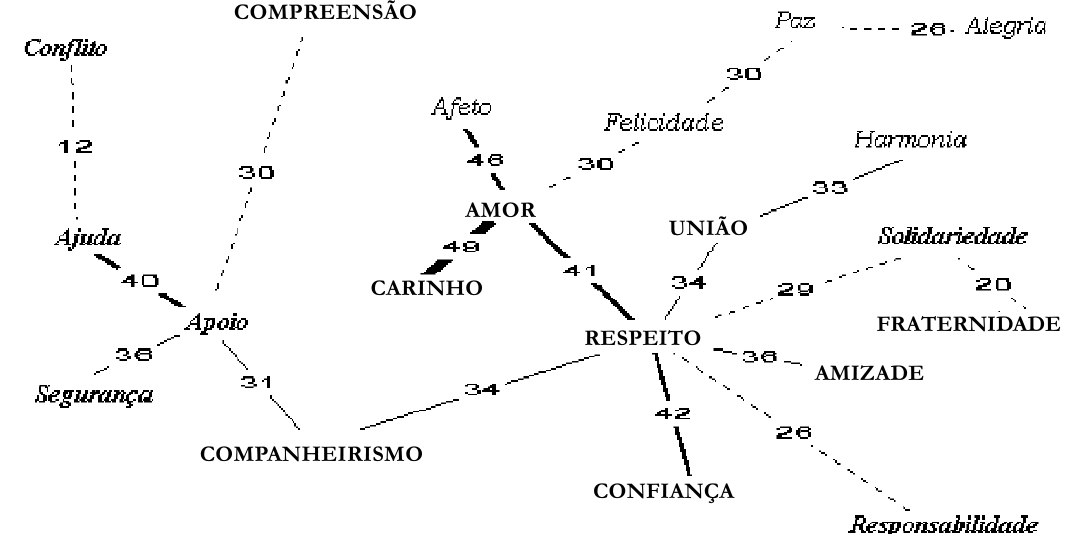
AMIZADEFRATERNIDADEUNIˆOAMORCOMPREENSˆO CONFIAN˙ARESPEITOCARINHO COMPANHEIRISMO Figura 3. Organiza(cid:231)ªo dos elementos da representa(cid:231)ªo social de (cid:147)fam(cid:237)lia(cid:148). Psicologia: Reflexªo e Cr(cid:237)tica, 2003, 16(3), pp.